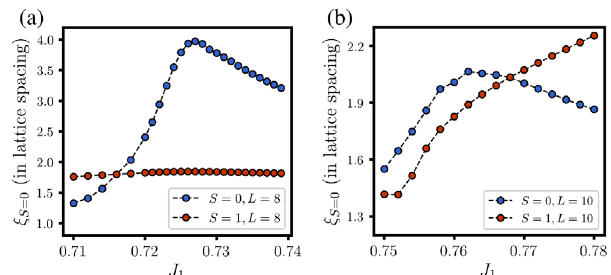
FIG. 18. Comparison between the L ¼ 8 and L ¼ 10 results at χ ¼ 4000 for the spin-singlet and -triplet correlation lengths. For L ¼ 8 , the peak of the ξ is located at J 1 ¼ 0 . 727 , while for S ¼ 0 L ¼ 10 the peak is located at J 1 ¼ 0 . 762 . Unlike the result at L ¼ 10 , the spin-triplet correlation length at L ¼ 8 does not grow much after the